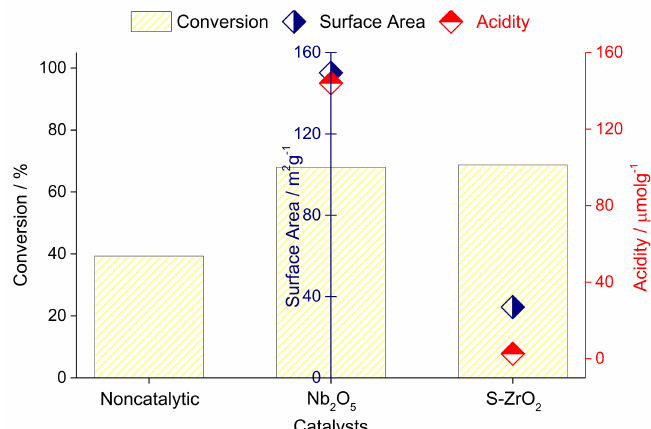
Figure 21. Oleic acid esterification reaction with methanol over Niobium oxide and sulfated zirconia. Reaction conditions: methanol:acid molar ratio (10), catalyst (5 wt% related to the oleic acid mass), reaction temperature (200 ◦ C), time (20 min) (adapted from